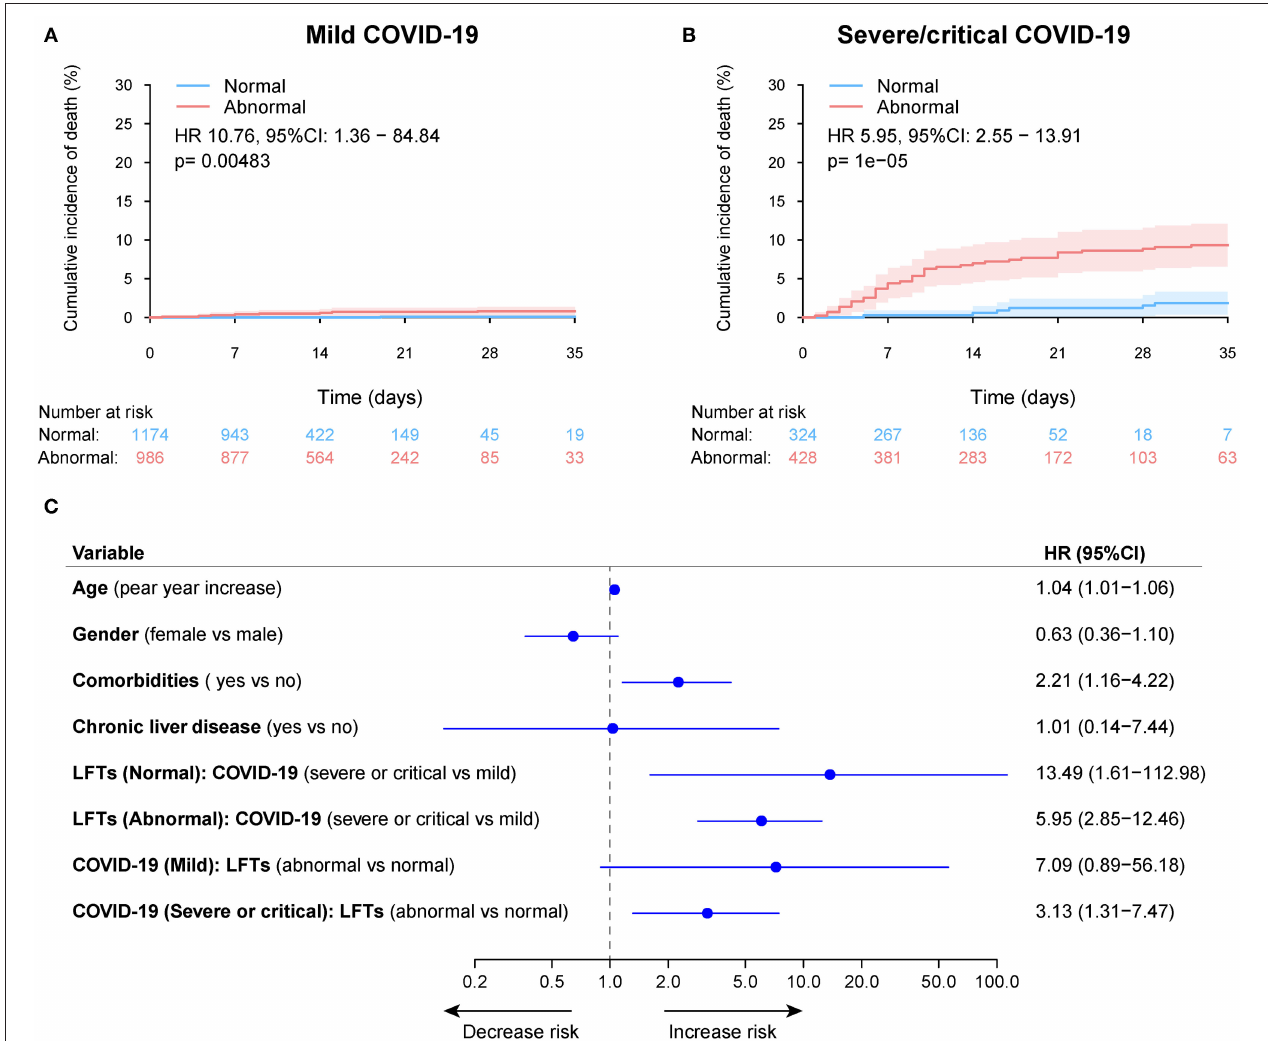
FIGURE 6 | Cumulative incidence of death according to admission abnormal vs. normal liver function tests (LFTs) and severity of COVID-19 infection. (A) Cumulative incidence of death in patients with abnormal vs. normal LFTs on admission and mild COVID-19 infection. (B) Cumulative incidence of death in patients with abnormal vs. normal LFTs on admission and severe/critical COVID-19 infection. (C) Forest plot showing the interaction test of the LFTs (normal vs. abnormal) and severity of COVID-19 infection (mild vs. severe/critical) on death after adjustment for potential confounders using the Cox multivariable regression models. P interaction = 0.521, showing a homogeneous effect of LFTs on death across the severity of COVID-19 infection. Comorbidities include hypertension, cardiovascular disease, diabetes, chronic pulmonary diseases, cerebrovascular disease, malignancy, and autoimmune disease. Chronic liver diseases include hepatitis B virus infection, hepatitis C virus infection, and autoimmune liver disease. COVID-19, coronavirus disease 2019; LFTs, liver function